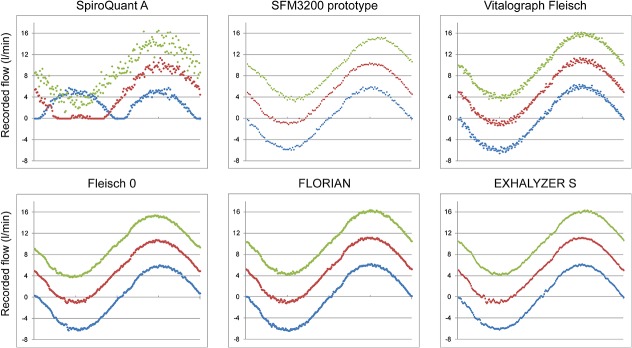
Graphic quality of signal at three levels of bias flow.Recordings from simulations at three levels of bias flow with simulated sinusoidal breathing (32 ml tidal volume, 60 breaths/minute). The colors indicate bias flow level; blue 0.0 L/min, red 5.0 L/min and green 10.0 L/min. The graphs represent one breath (1.0 s).